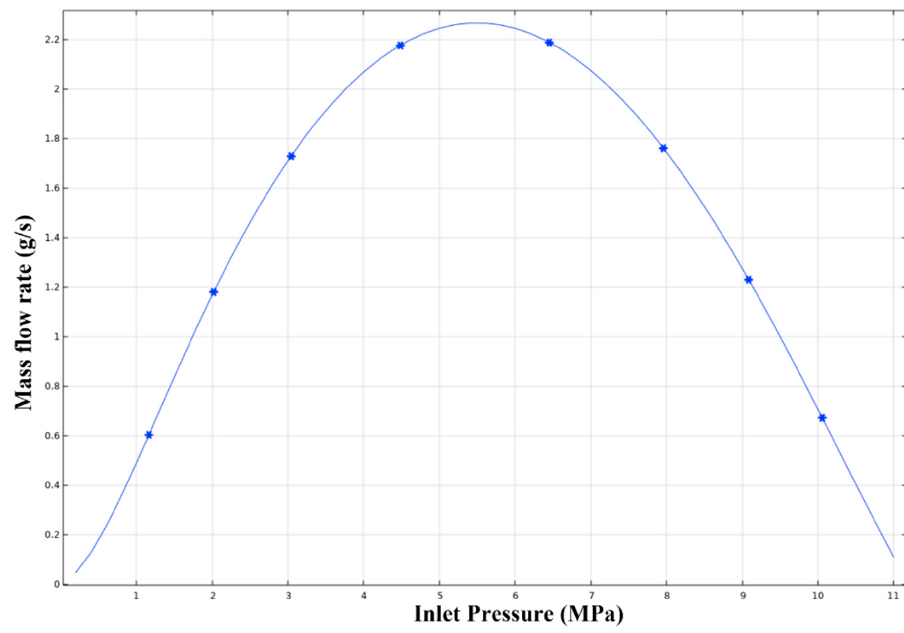
Figure 8. Variation of the mass flow rate for different inlet pressure conditions, between 0.1 MPa and 11 MPa, obtained from the fully coupled multiphysics simulations at the design conditions listed in Table 1.